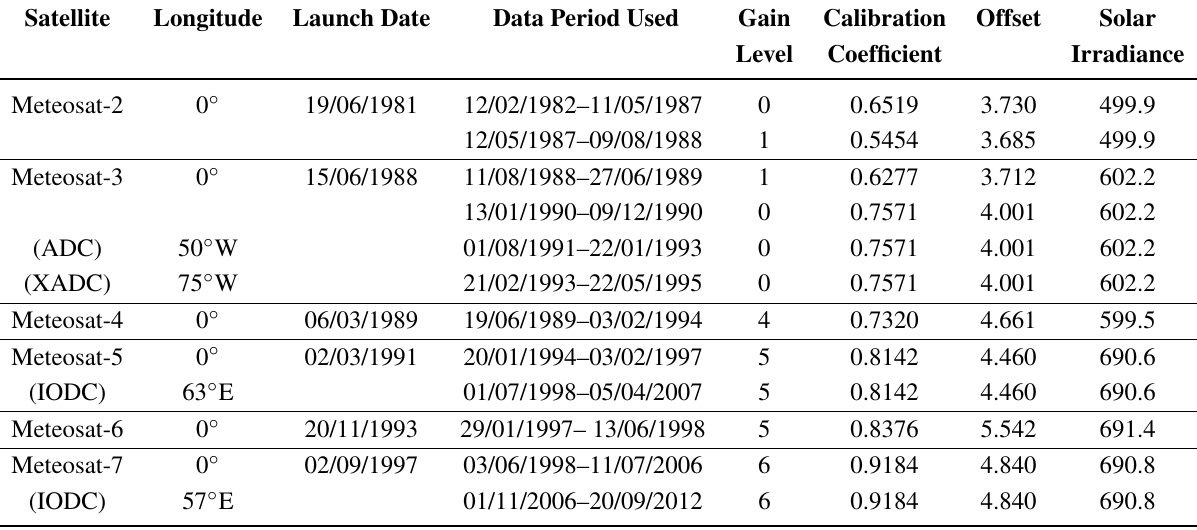
Table 2. For each of the MFG satellites the following information is given: the longitude at which the instrument was operational, the launch date, the data period at that longitude that is used in this paper, the gain level, the calibration coefficient (in W · m − 2 sr − 1 / DC), the time averaged offset value (in DC), and the solar irradiance (in W · m − 2